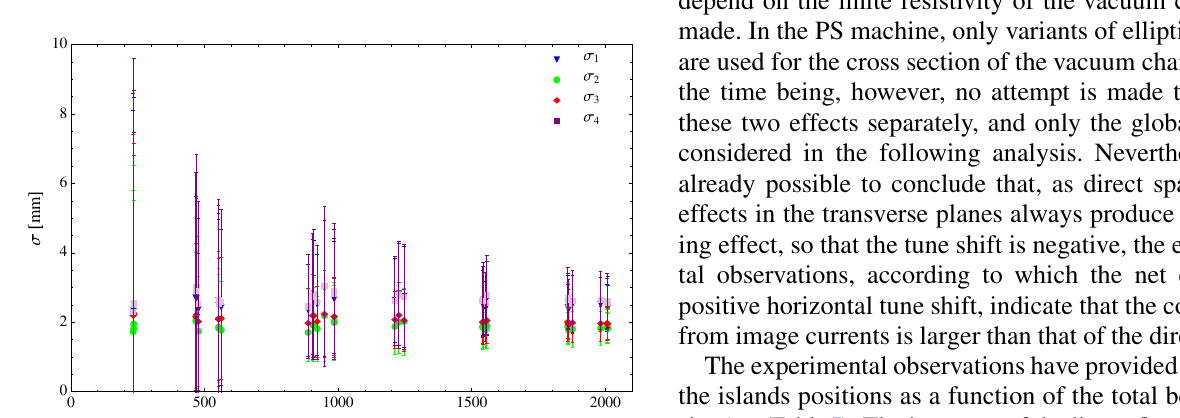
FIG. 10. Evolution of the trapping fraction (cid:9) as a function of the total beam intensity. The error bars are derived from the errors associated to the fit procedure for obtaining the parameters N N isl , initial . The data reported are those from the first and second measurement campaigns. No meaningful difference between the two campaigns or the type of longitudinal structure is visible.